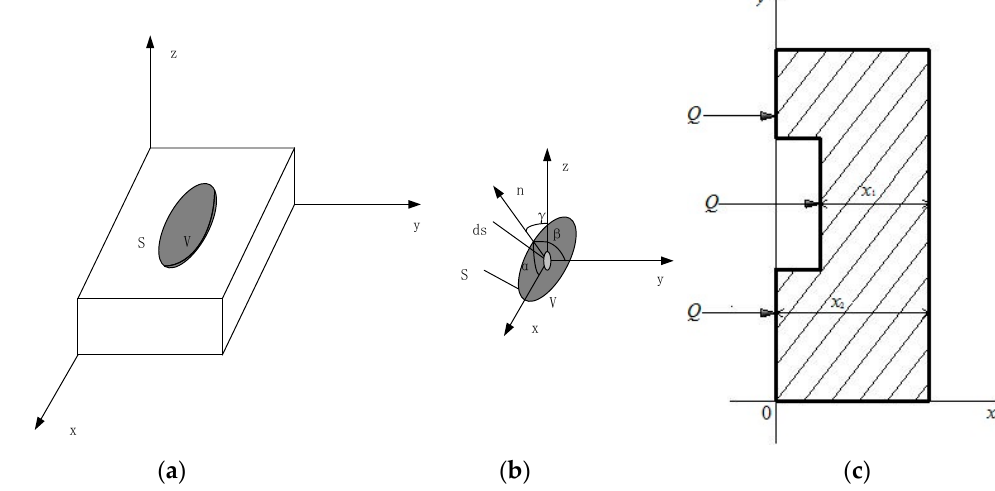
Figure 1. Schematic diagram of heat conduction theory: ( a ) Solid model; ( b ) Diagram of infinitesimal analysis; ( c ) A slab of specimen is excited by a pulsed heat source.